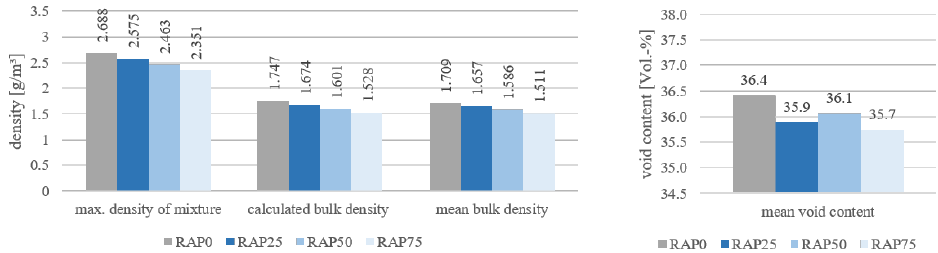
Figure 3. Mean maximum, calculated and experimentally determined bulk densities and void contents of all specimens.